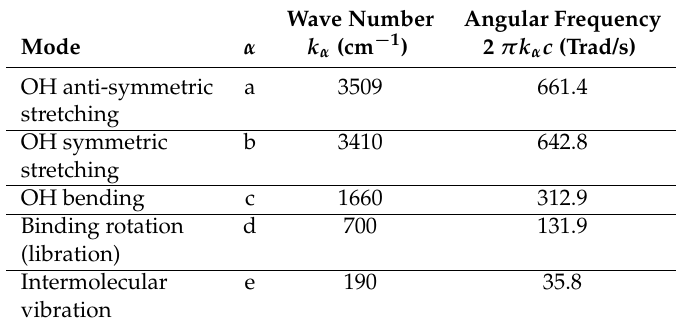
Figure 5. Modes of H 2 O molecular motions of ( a ) anti-symmetric stretching; ( b ) symmetric stretching; ( c ) bending; ( d ) libration; and ( e ) intermolecular vibration. Table 1. Wavenumbers and angular frequencies for various molecular vibration modes of water ( c : light